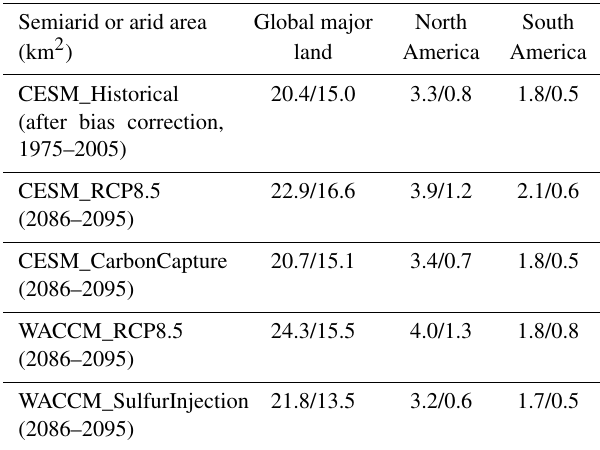
Table 3. Dryland area (millions of square kilometers) for semiarid and arid types. North America is 15–60 ◦ N and 230–300 ◦ E. South America is 60 ◦ S–10 ◦ N and 280–330 ◦